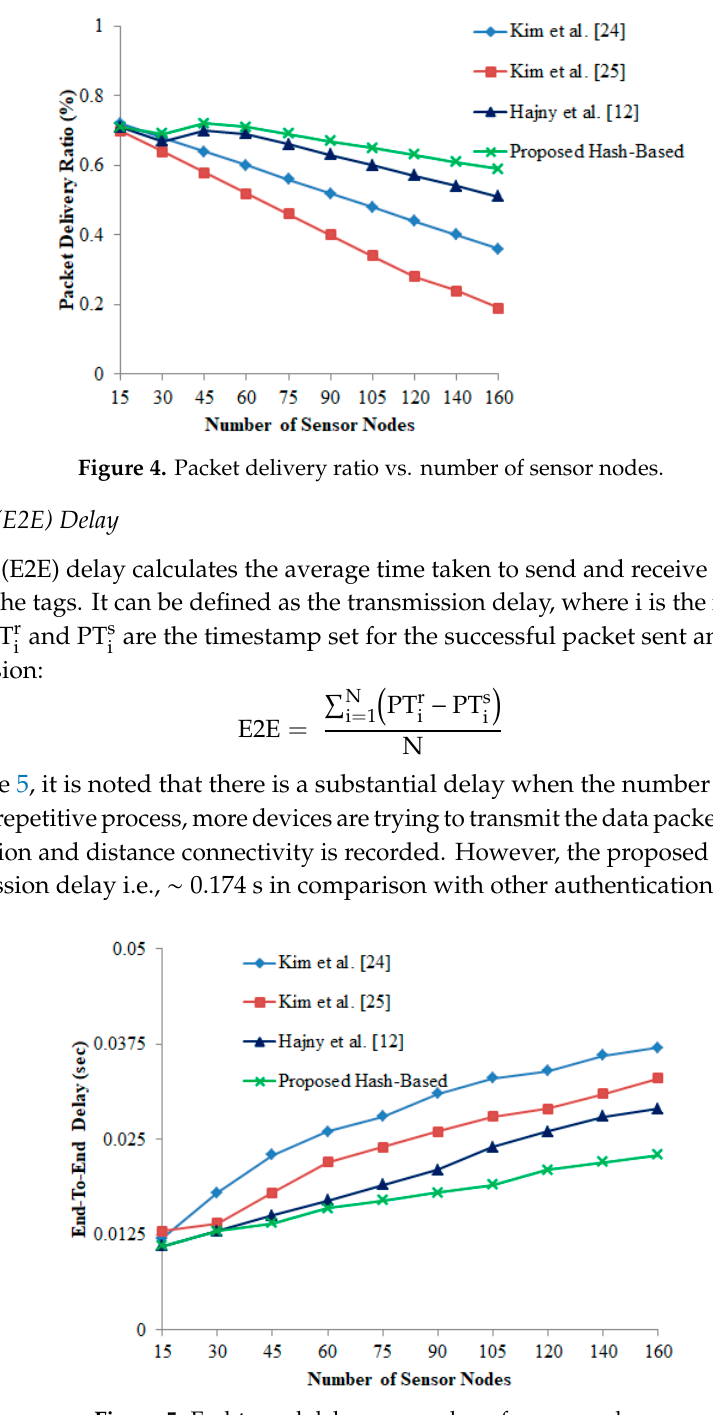
Figure 5. End-to-end delay vs. number of sensor nodes.